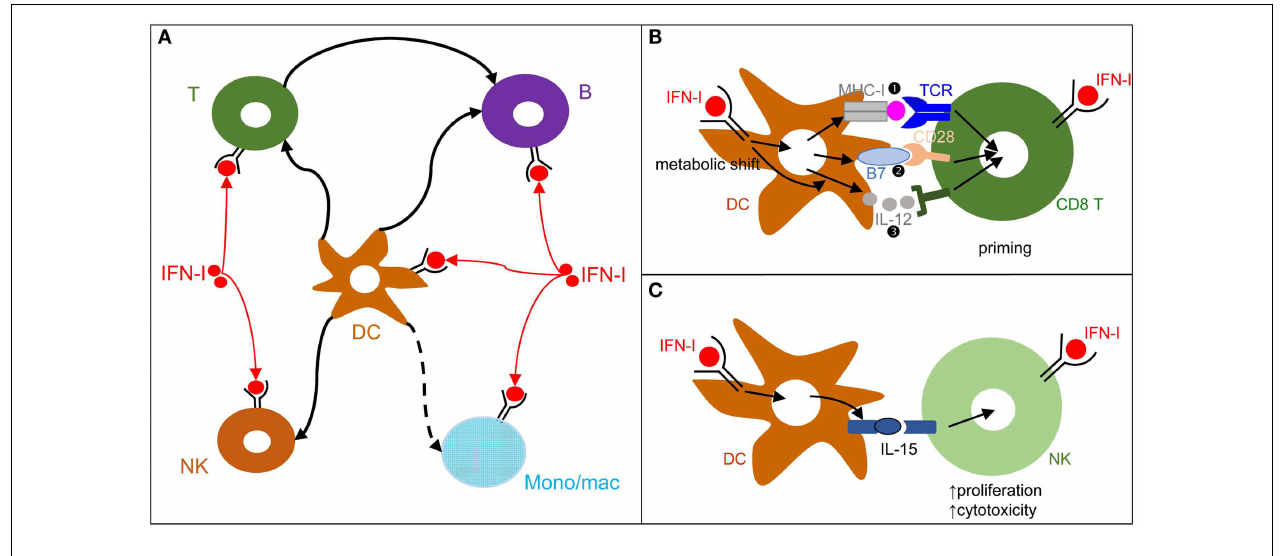
cell priming and functional polarization. IFN-I can modulate all three types of signals delivered by DC toT cells: MHC-I/antigenic peptide complexes ( ), co-stimulation ( ), and cytokines ( ).This depends both on IFN-I-dependent transcriptional induction in DC of some of the corresponding genes and on IFN-I-dependent metabolic reprogramming of DC. (C) DC cell-intrinsic responses to IFN-I endow them to deliver appropriate signals, in particular IL-15 trans-presentation, for NK cell activation. See main text for further